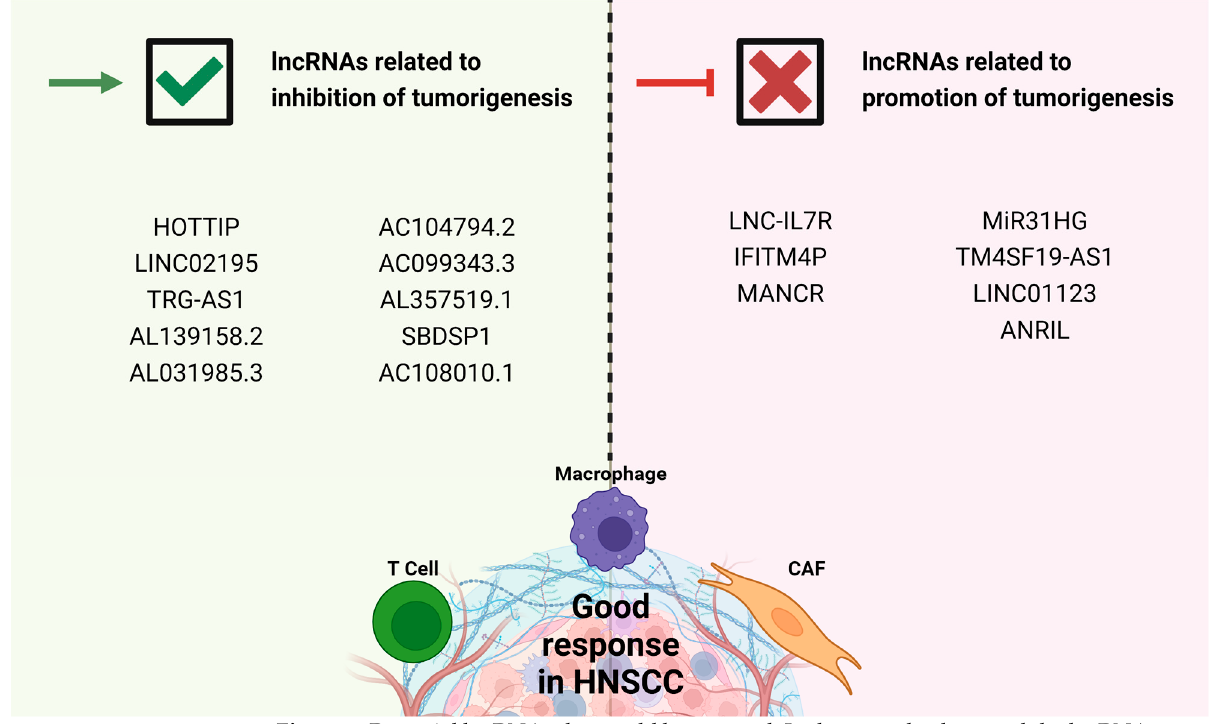
Figure 2. Potential lncRNAs that could be targeted. In the green background the lncRNAs associated to inhibition of tumorigenesis are listed; the therapeutic strategies could be directed to induce them within the TME. In the pink background there is a list of lncRNAs related to promotion of tumorigenesis in HNSCC; the therapeutic strategy could be directed to inhibit their expression within the TME.